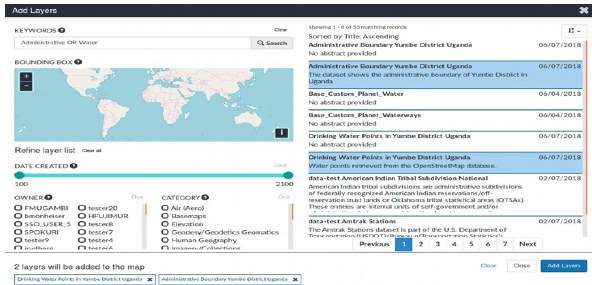
Figure 2. A window from the web instance of GeoSHAPE platform.